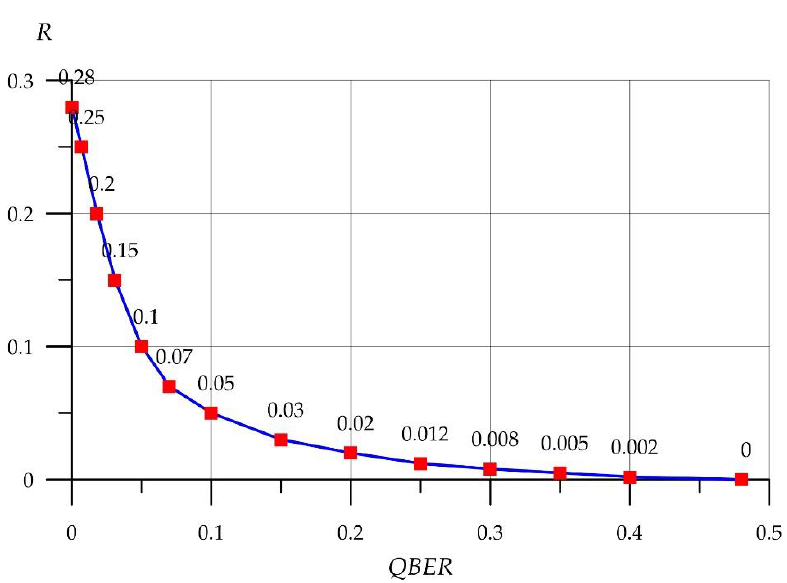
Figure 4. Error threshold for protocol BB84.